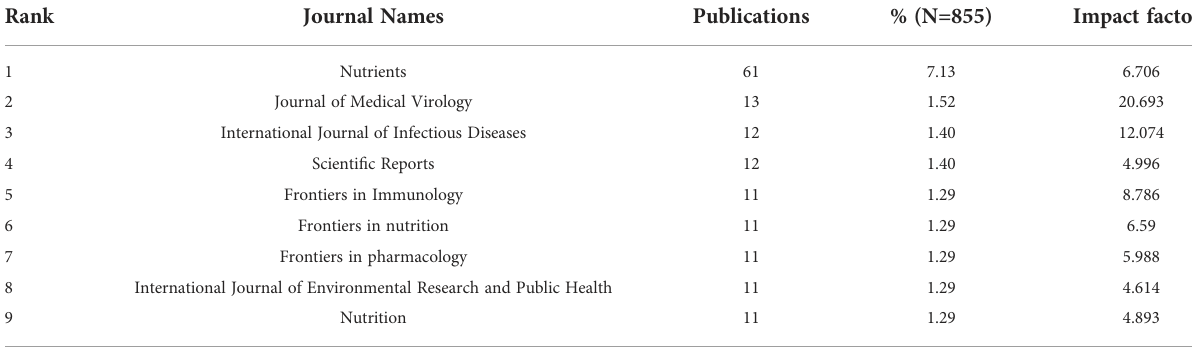
TABLE 1 Top 9 journals ranked by the number of publications.